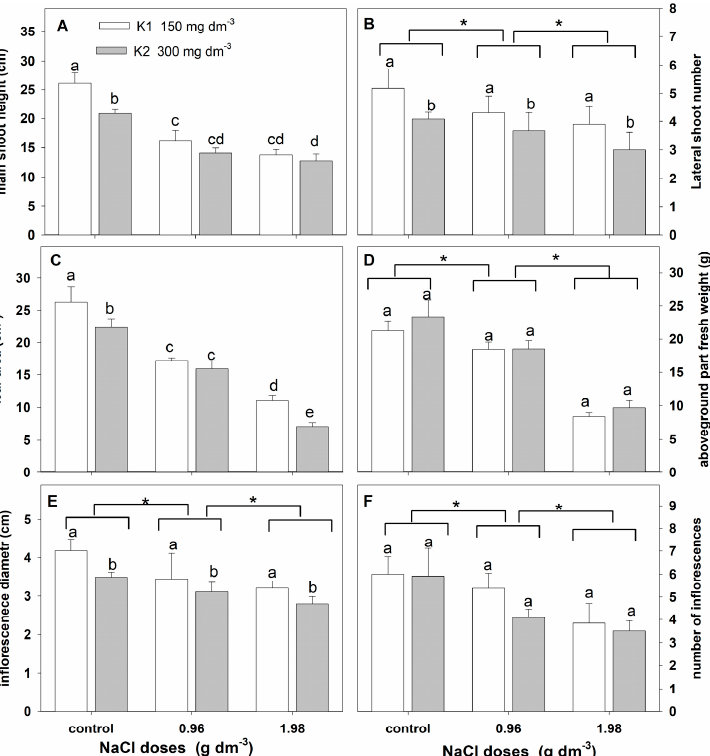
Figure 6. The effect of salinity doses on growth parameters in zinnia grown in the peat substrate supplemented with two potassium doses. In ( A , C ), different letters show statistically significant differences between combinations. In ( B , D – F ), letters a and b show a significant effect of potassium doses, and an asterisk (*) shows a significant effect of salt doses. Values are expressed as the means (n = 15) ± standard deviation.